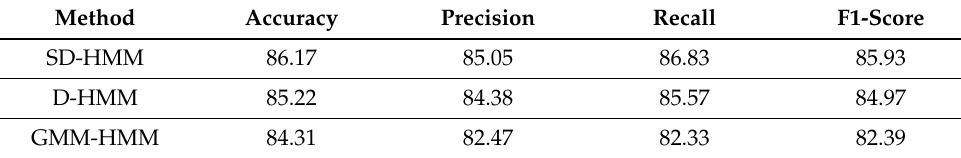
Table 5. Model performance evaluation results for the UCI HAR